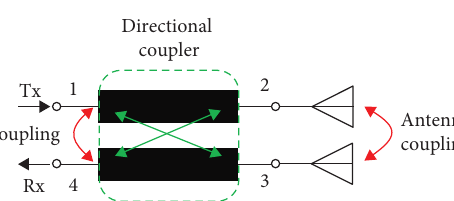
Figure 2: Schematic of Tx/Rx antennas with single directional